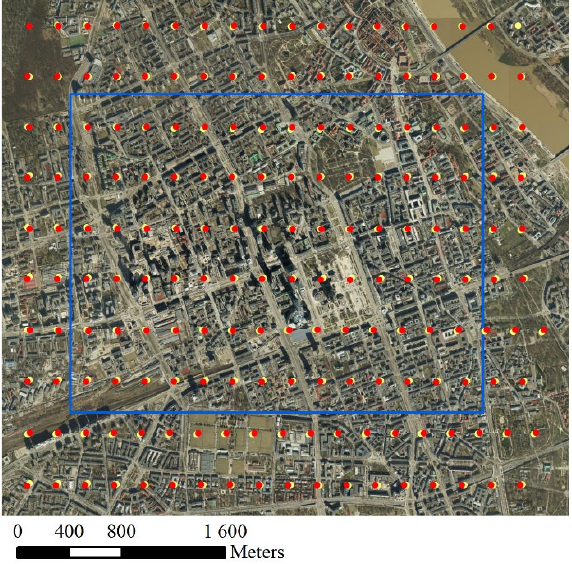
Figure 1. The test filed (marked with a blue outline) – central part of the city (Warsaw) and camera positions from 2018 and 2019 (marked with red and yellow dots) datasets.